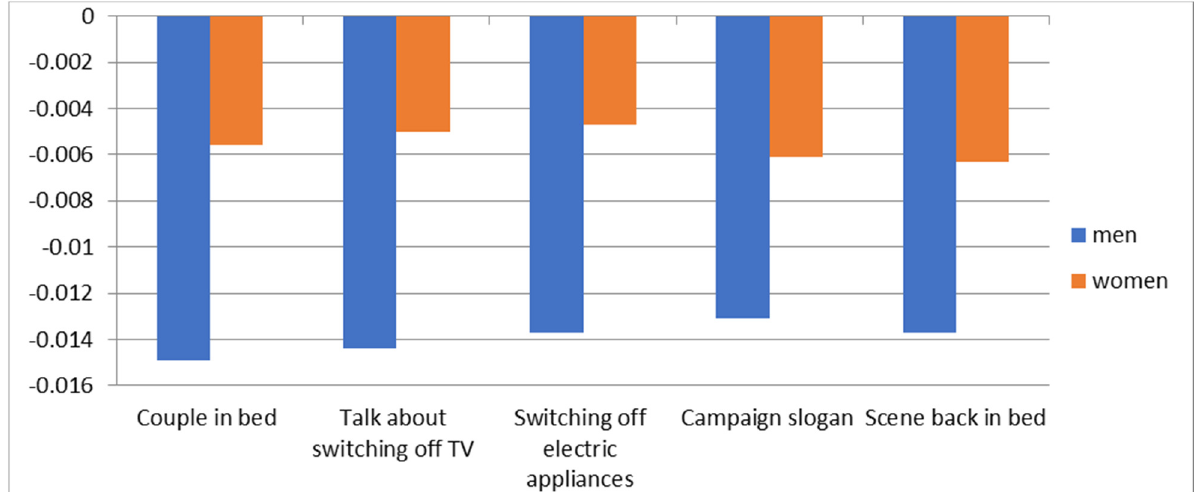
Figure 6. Average values of the normalized male and female engagement indices for the “turn off power, turn on savings” media message.